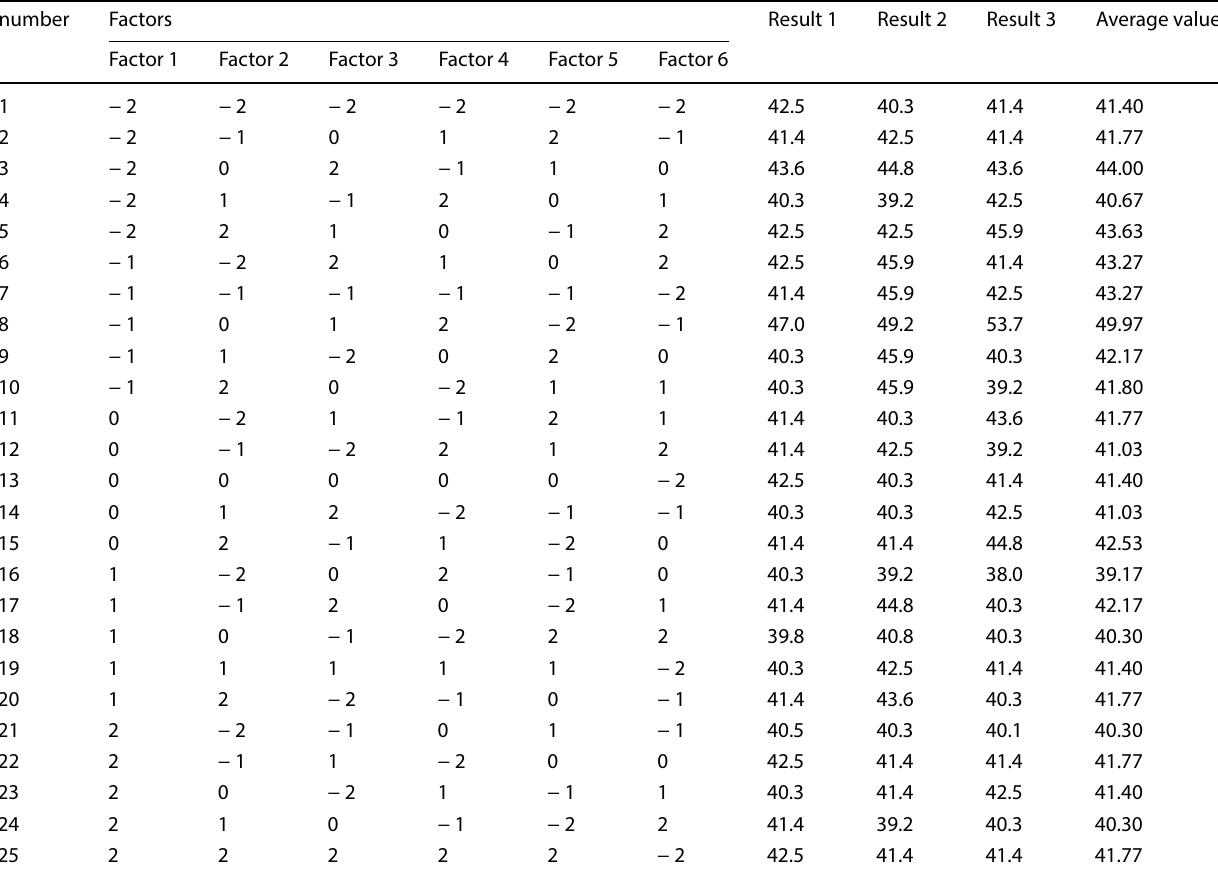
Table 3 Results of orthogonal